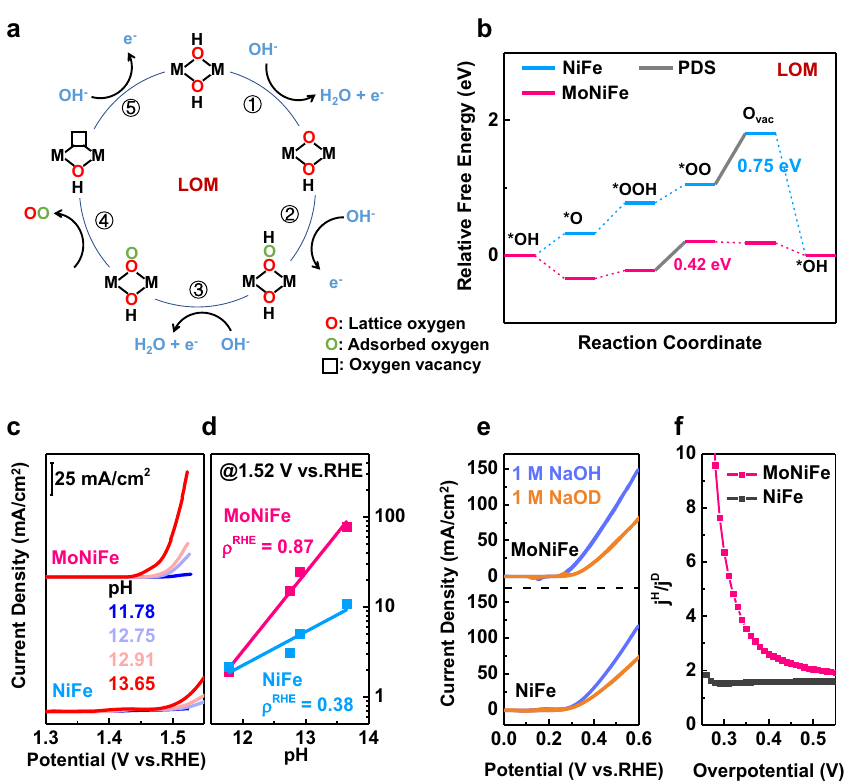
Fig. 4 OER mechanism revealed by DFT calculation, pH dependence, and deuterium isotopic labeling experiments. a Schematic illustration and b Gibbs free energy diagrams of the LOM pathway on NiFe and MoNiFe (oxy)hydroxide. c Linear sweep voltammetry (LSV) curves for NiFe and MoNiFe (oxy) hydroxide measured in KOH with pH = 11.78, 12.75, 12.91, and 13.65. d OER current density at 1.52 V versus RHE plotted in log scale as a function of pH, from which the proton reaction orders ( ρ RHE = ∂ log i / ∂ pH) were calculated. e LSV curves for NiFe and MoNiFe (oxy)hydroxide measured in 1 M NaOH and 1 M NaOD solution. The LSV curves are without iR compensation. f The kinetic isotope effect of MoNiFe and NiFe (oxy)hydroxide. j H and j D are referred to the current density measured in NaOH and NaOD solution,